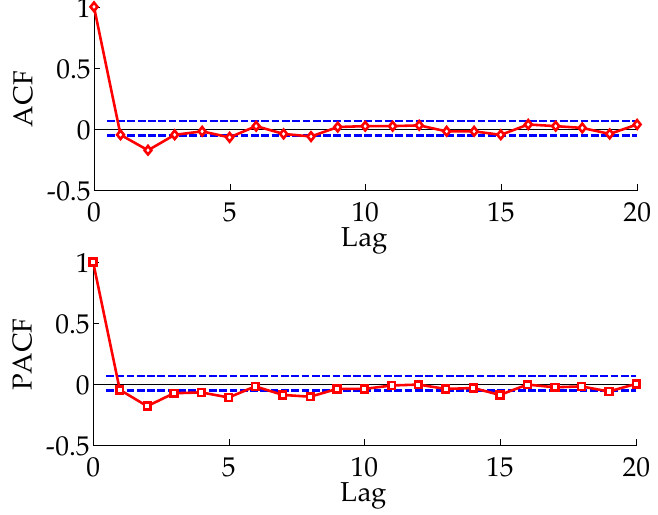
Figure 9. The autocorrelation (ACF) and partial ACF (PACF) for the {X 3t } series.